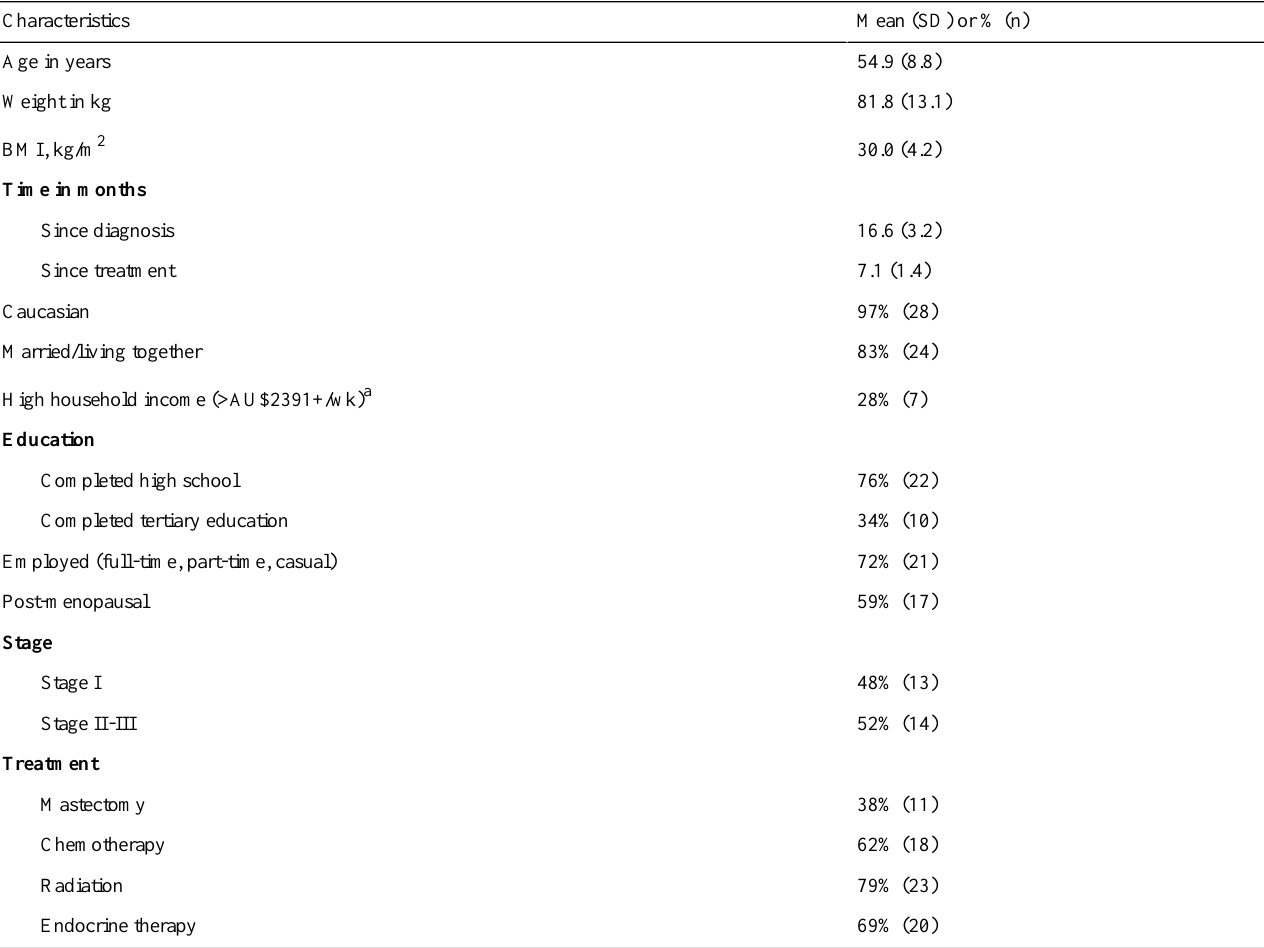
Table 2. Baseline characteristics of participants who consented to the extended contact intervention